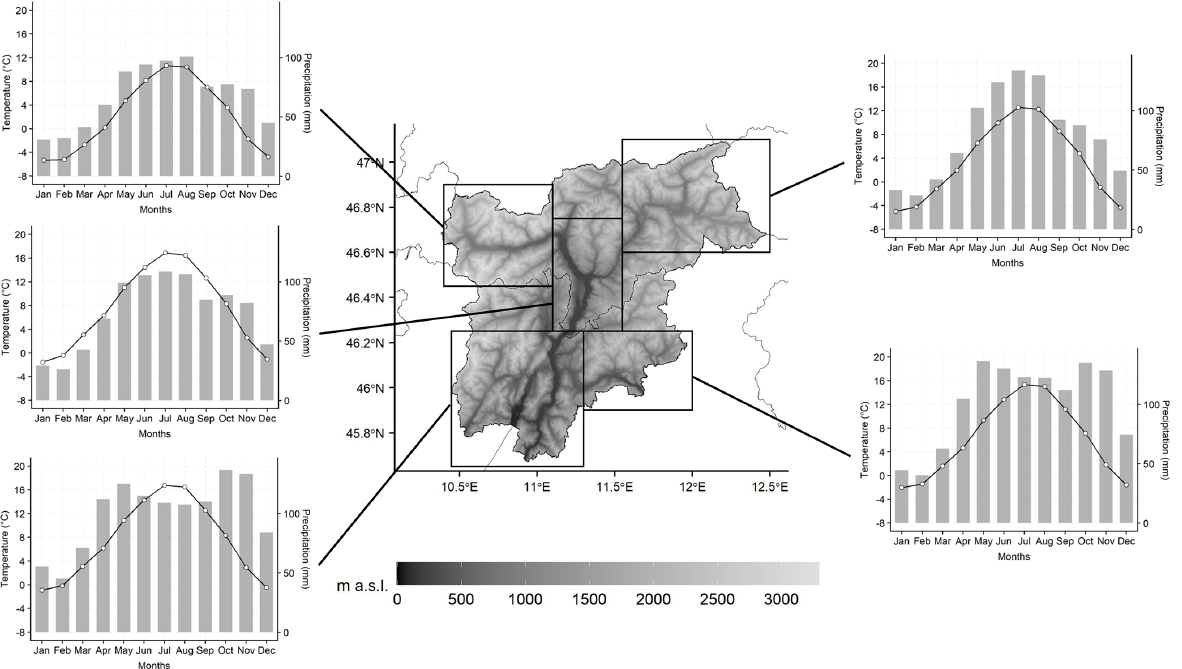
Figure 10. Mean subregional annual cycles of monthly mean temperature and total precipitation based on the 1981–2010 climatologies for five distinct areas.